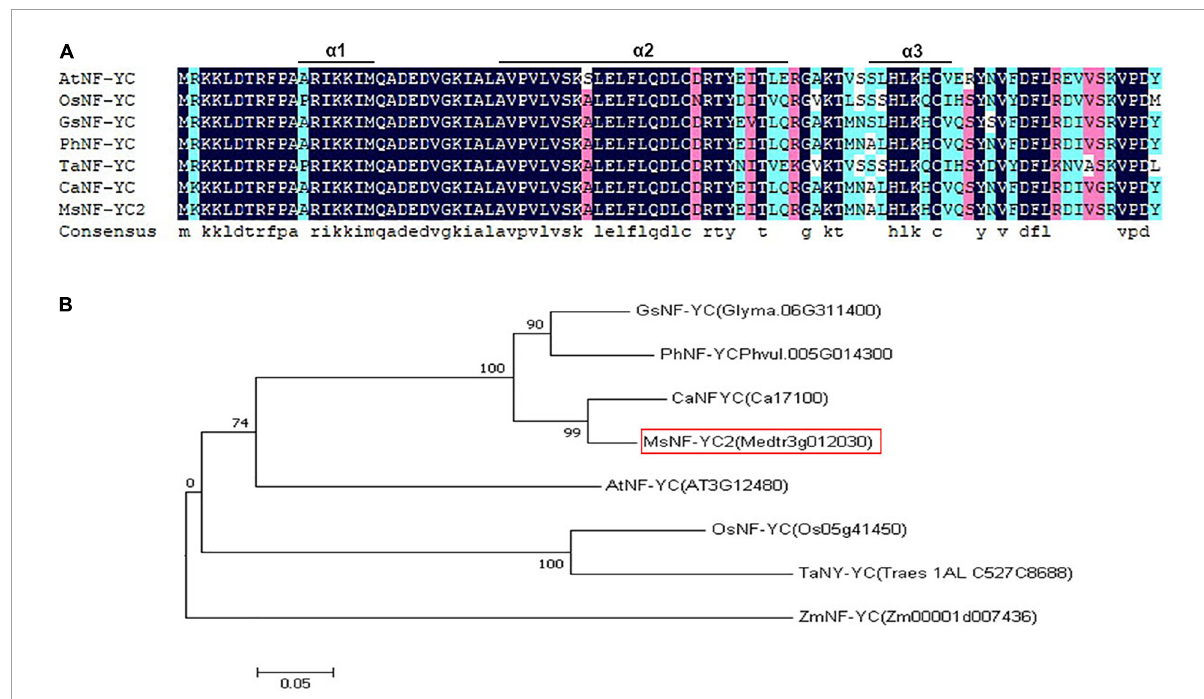
FIGURE1 Alignment of sequences and phylogenetic tree of the NFYC proteins. (A) Alignment of sequences of the NFYC proteins MsNFYC2 and homologs from other species. (B) Phylogenetic tree of NFYC proteins from alfalfa and other species.